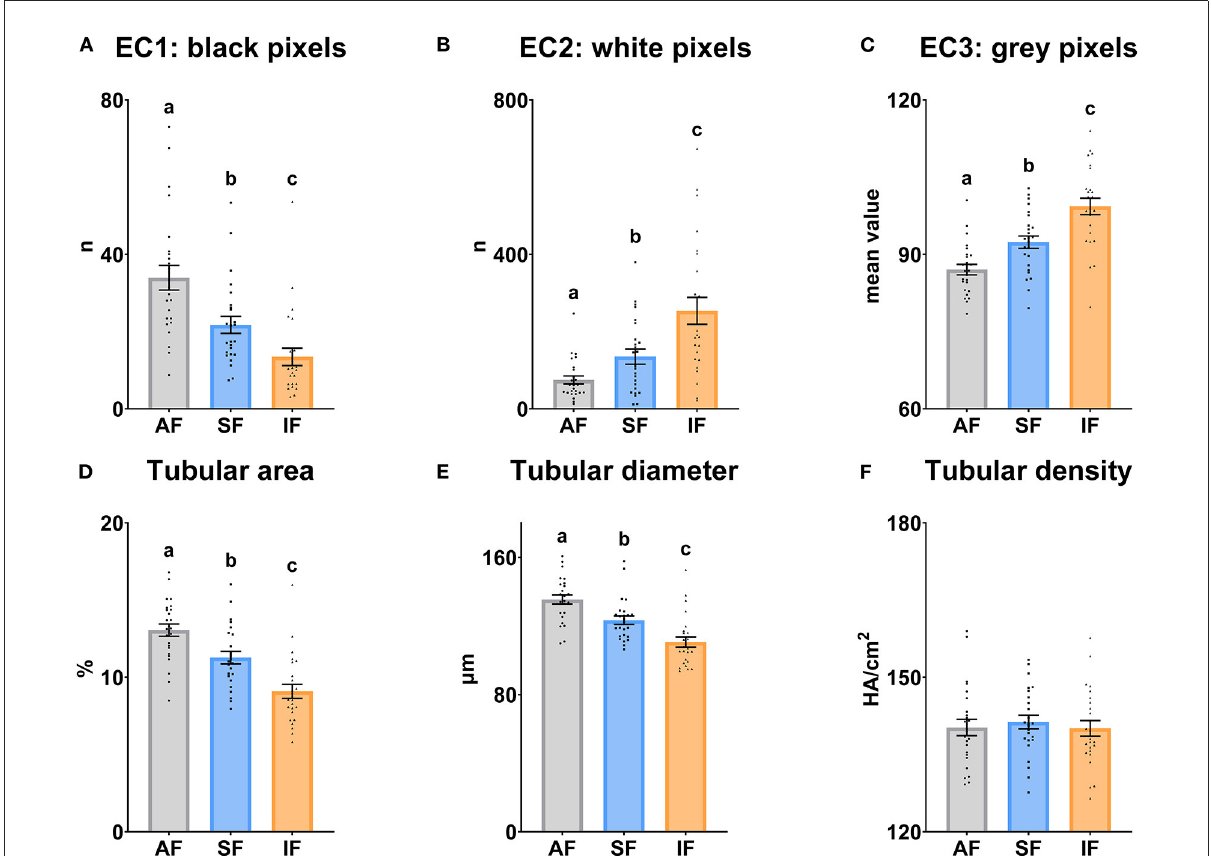
FIGURE3 Echotexture characteristics of the ram testes according to semen collection frequencies. (A) EC1, Ecotext 1 (black pixels); (B) EC2, Ecotext 2 (white pixels); (C) EC3, Ecotext 3 (mean value of gray pixels); (D) Tubular area, proportion (%) of the total area corresponding with the lumen of the seminiferous tubules; (E) Tubular diameter, mean diameter ( µ m) of the lumen of the seminiferous tubules; (F) Tubular density, the density of hypoechogenic areas per cm 2 corresponding with the seminiferous tubules. The same 25 males were analyzed in each experimental group (AF, abstinence semen collection frequency; SF, standard semen collection frequency; IF, intensive semen collection frequency). Graph dots represent individual male values. Means ( ± SEM) are shown. Different lowercase superscripts letters (a–c) indicate differences ( P ≤ 0.05) among the semen collection